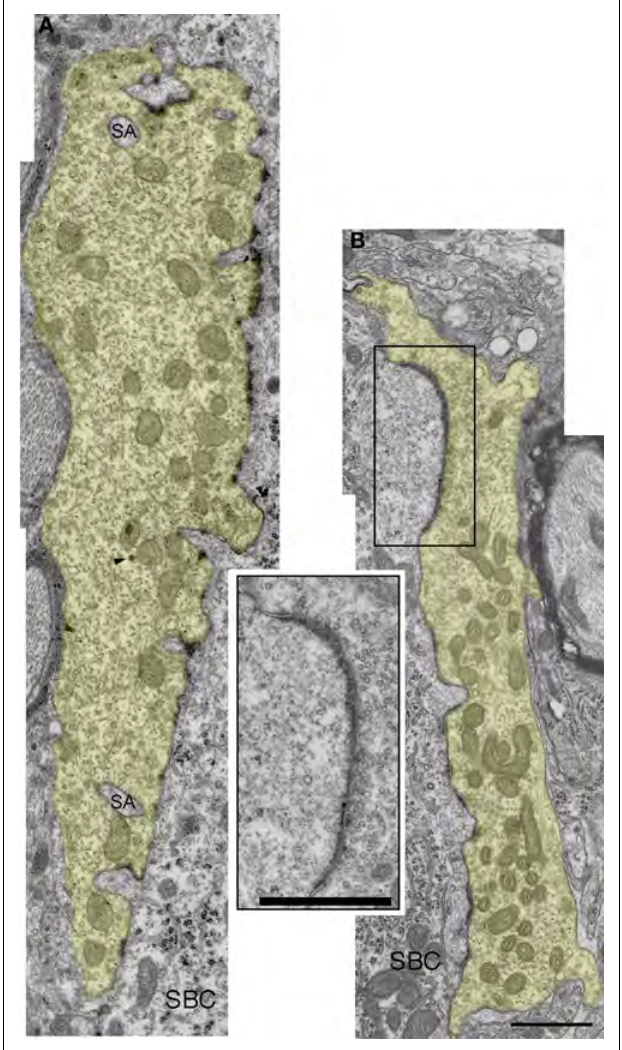
FIGURE 4 | Electron micrographs of endbulbs from a 10-day (A) and 20-day (B) deaf white kitten. (A) The surface between the endbulb (yellow) and SBC membranes has fl attened out compared to 0- and 5-day endbulbs and somatic appendages (SA) have decreased. The number of large dense-core vesicles (arrowhead) has also diminished. (B) Endbulb-SBC surface contact continues to fl atten and SBC inclusions have essentially vanished in the 20-day endbulb. PSDs appear as asymmetric membrane thickenings with associated synaptic vesicles. Extremely long, fl at PSDs are common in young deaf animals (inset). Scale bars equal 1